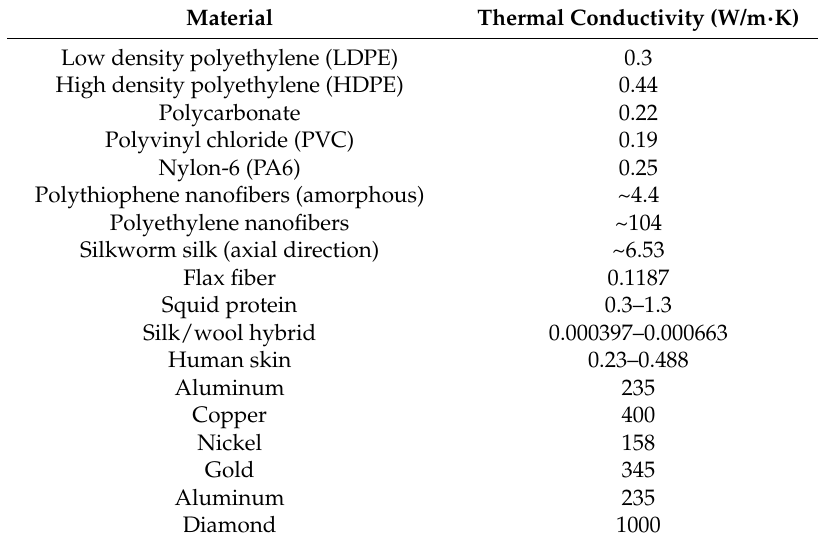
Table 1. Thermal conductivity values of common polymers and metals at room temperature